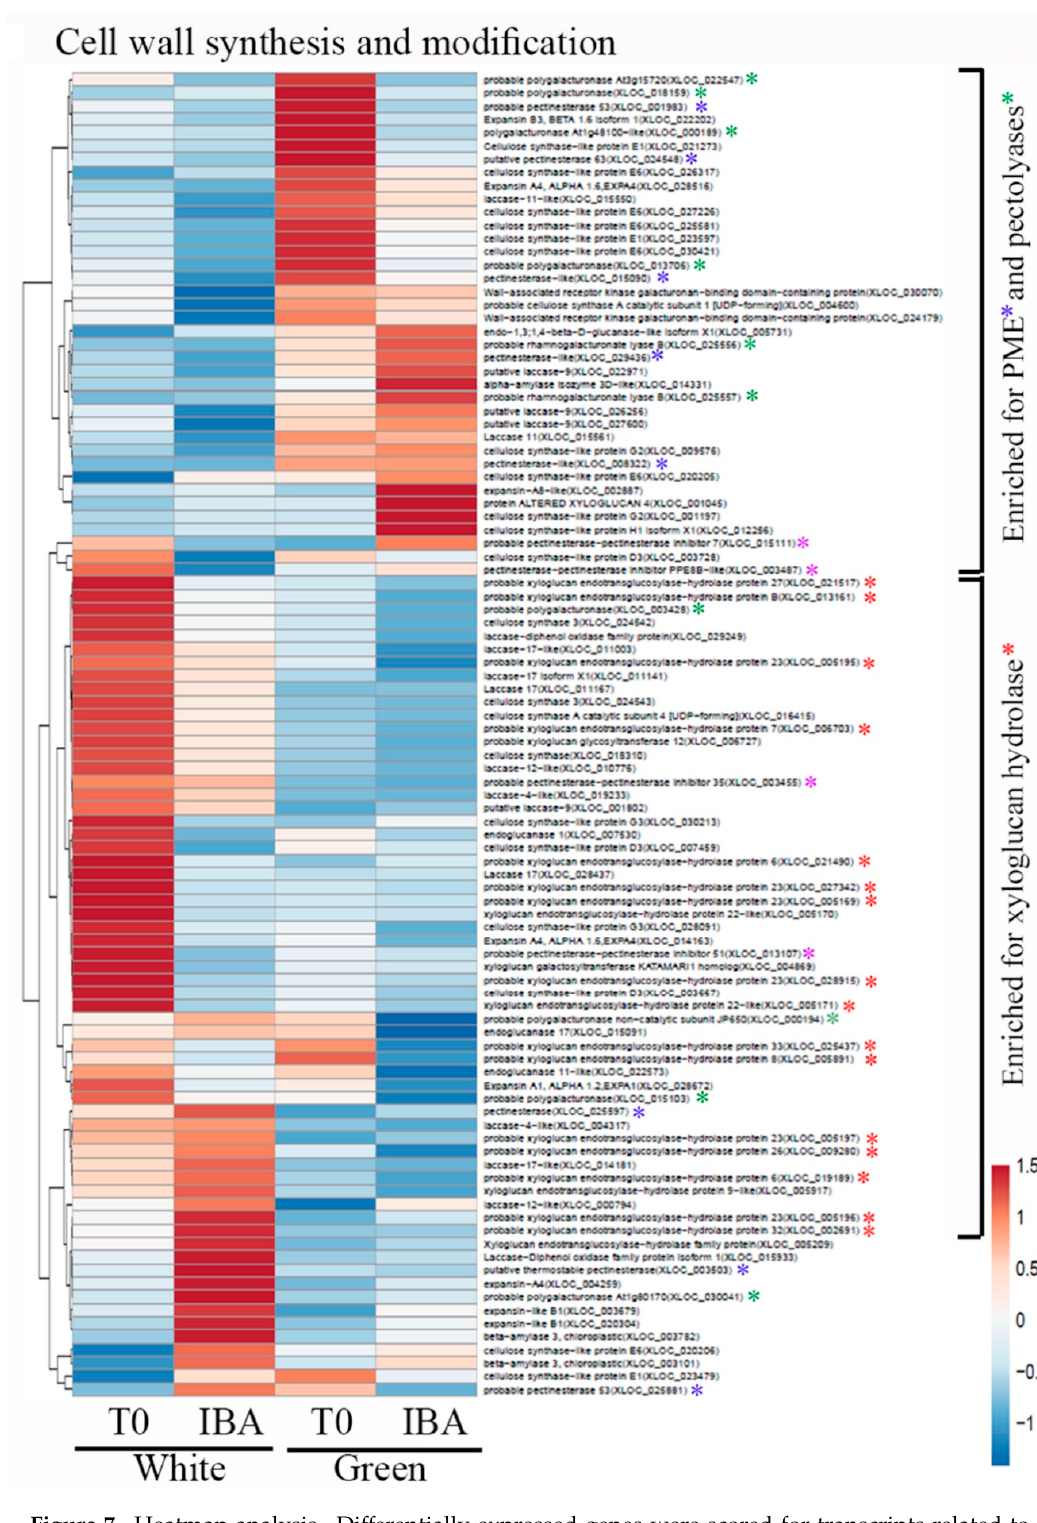
Figure 7. Heatmap analysis. Differentially expressed genes were scored for transcripts related to cell wall-modifying enzymes. Red asterisks show xyloglucan endotransglucosylases/hydrolases, blue asterisks—pectin methylesterase (PME), green asterisks—pectolyases such as polygalacturonase and rhamnogalaturonases, and purple asterisks—pectin methylesterase inhibitor PMEI.